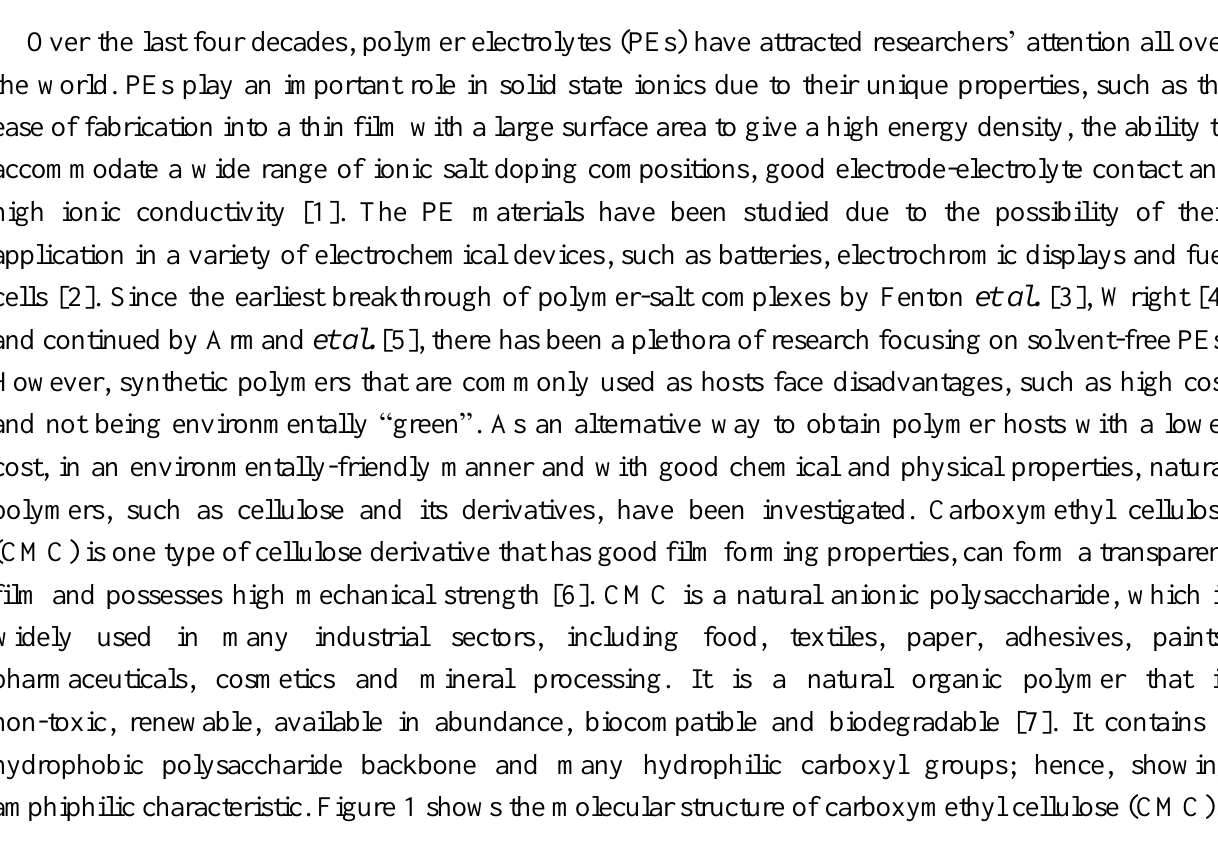
Figure 1. The molecular structure of carboxymethyl cellulose